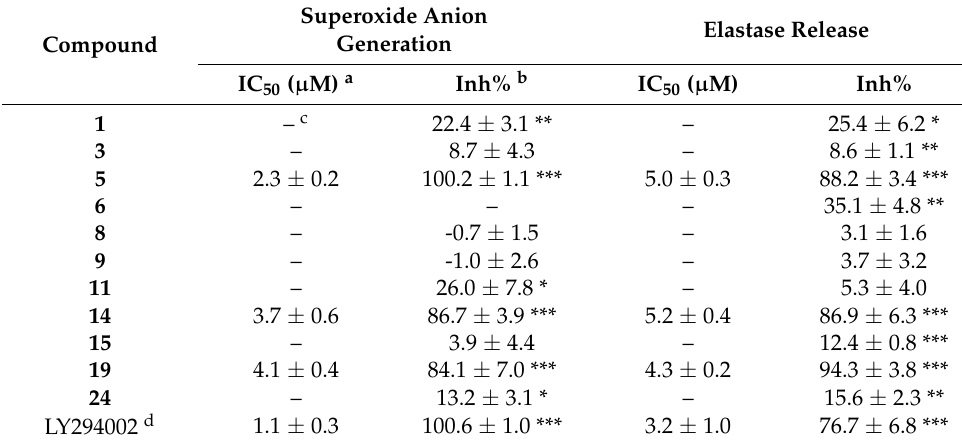
Table 3. Inhibitory effects of isolated compounds on superoxide anion generation and elastase release by human neutrophils in response to fMLF/CB. Compound